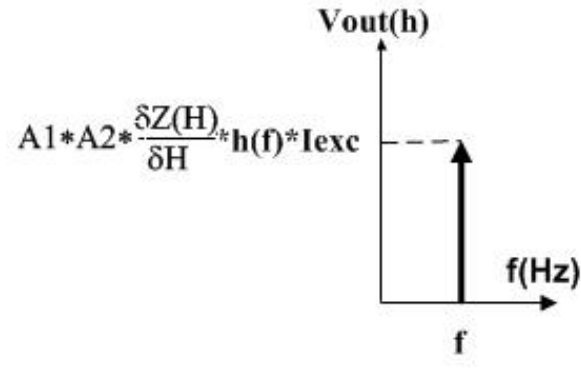
Figure 8. Frequency domain of GMI signal (Vgmi3) after high pass filter.